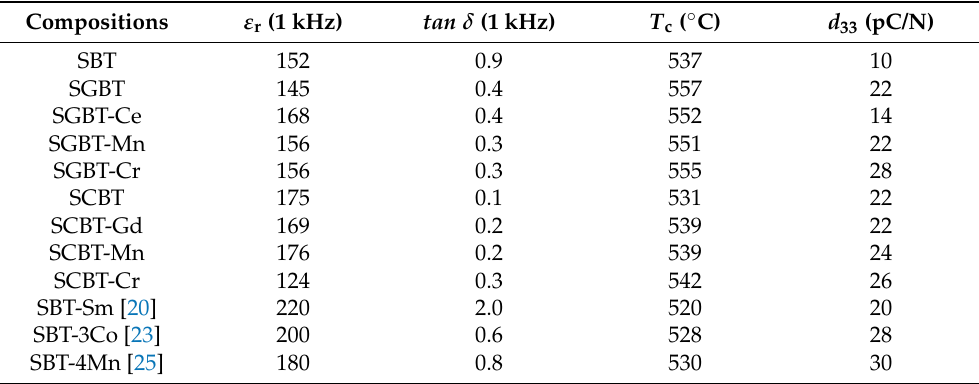
Table 4. Comparison of electrical properties between the oxide-modified SBT ceramics and other compositions